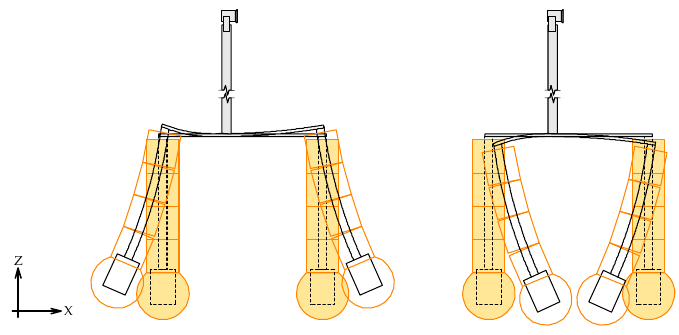
Figure 11. Schematic of the response mode for the 1.7 s wave period.